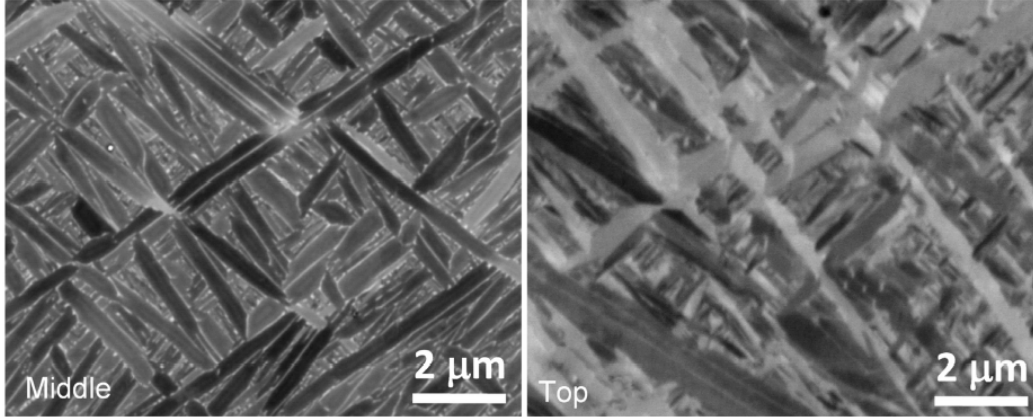
Figure 12. Scanning electron microscopy (BSE) of SLM fabricated sample S3 in the middle and top regions